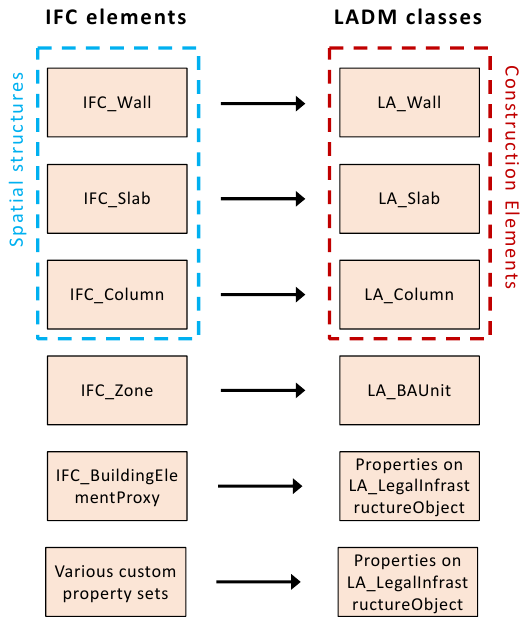
Figure 8 . Mapping of IFC elements of transport infrastructure objects to the LADM concept.